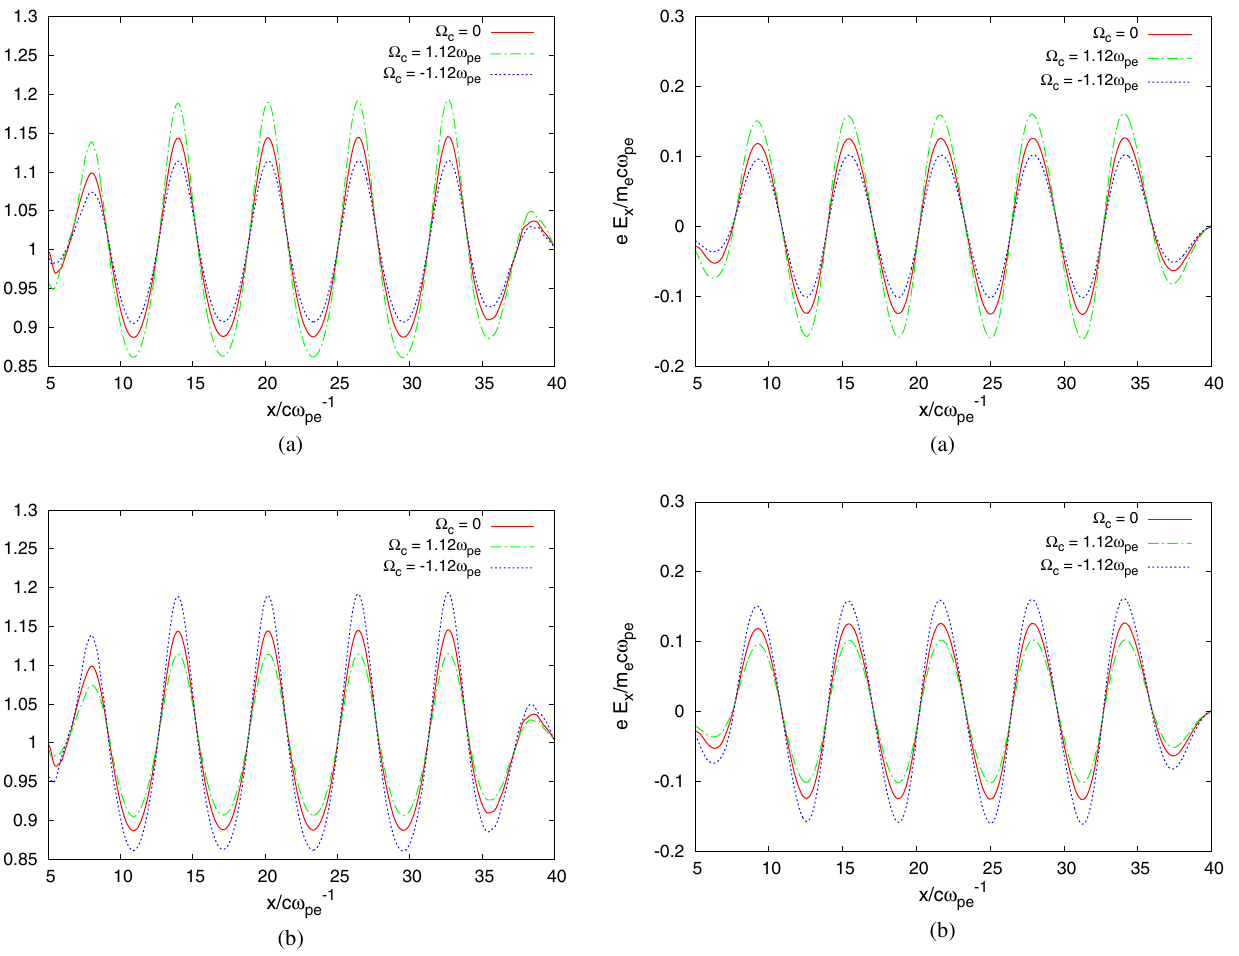
FIG. 3. Comparison of wakefields E x generated by propagation of (a) RCP and (b) LCP laser pulses in a nonmagnetized plasma Ω 0 (solid red line), plasma which are embedded in an c ¼ external magnetic field in positive x direction Ω c ¼ 1 . 12 ω pe (green dash dot line) and negative x direction Ω c ¼ − 1 . 12 ω pe ≃ 40 after the start of (blue dot line) at t= ω − 1 pe